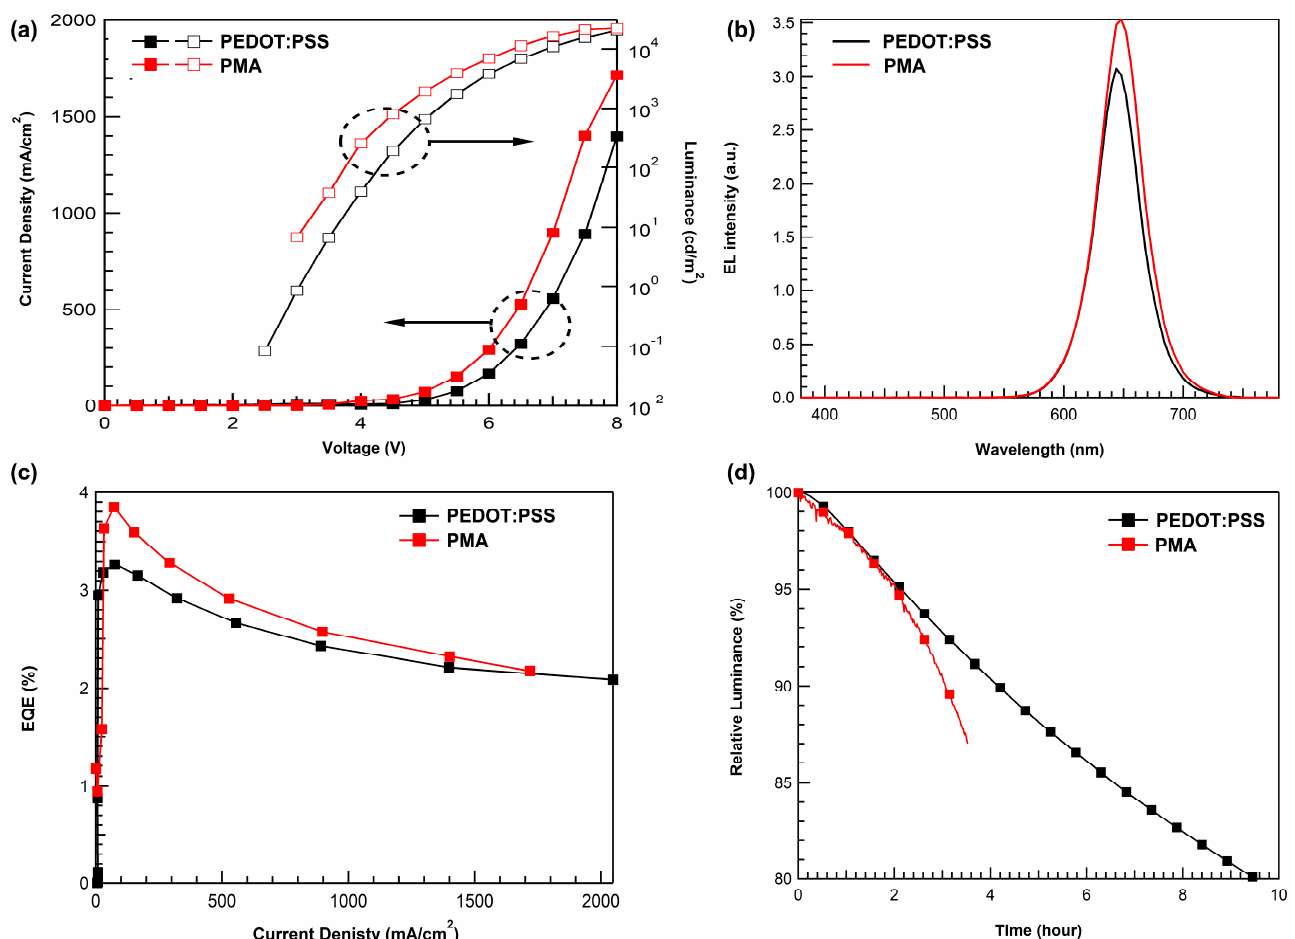
Figure 7. QD-EL device characteristics with PEDOT:PSS and PMA using cyclohexanone: ( a ) cur- rent density–voltage–luminance, ( b ) electronic luminance spectra, ( c ) external quantum efficiency– luminance, and ( d ) lifetime test at initial luminance of 1000 nit. Table 3. Comparing QD-EL device performance with PEDOT:PSS and PMA using cyclohexanone. L (cd/m 2 ) HIL V on at 1 nit (V) EQE max (%) PE max (lm/W) at 8 V